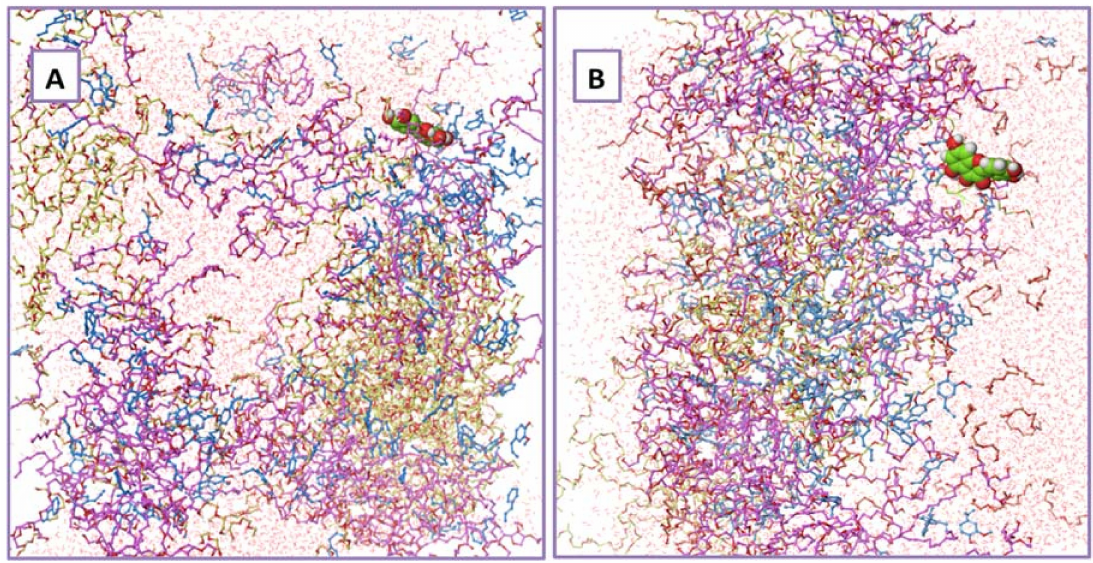
Figure 6. Formation of gel inside the water for the formulation used in this study. ( A ) The formulation components at 275 K; and ( B ) the formulation components at 313 K. Quercetin is represented in the form of a CPK model with green color, whereas the cinnamon oil is represented in cyan color, Carbitol ® is represented in pink color, tween 80 is represented in brown color and poloxamer 407 is represented with yellow color ball and